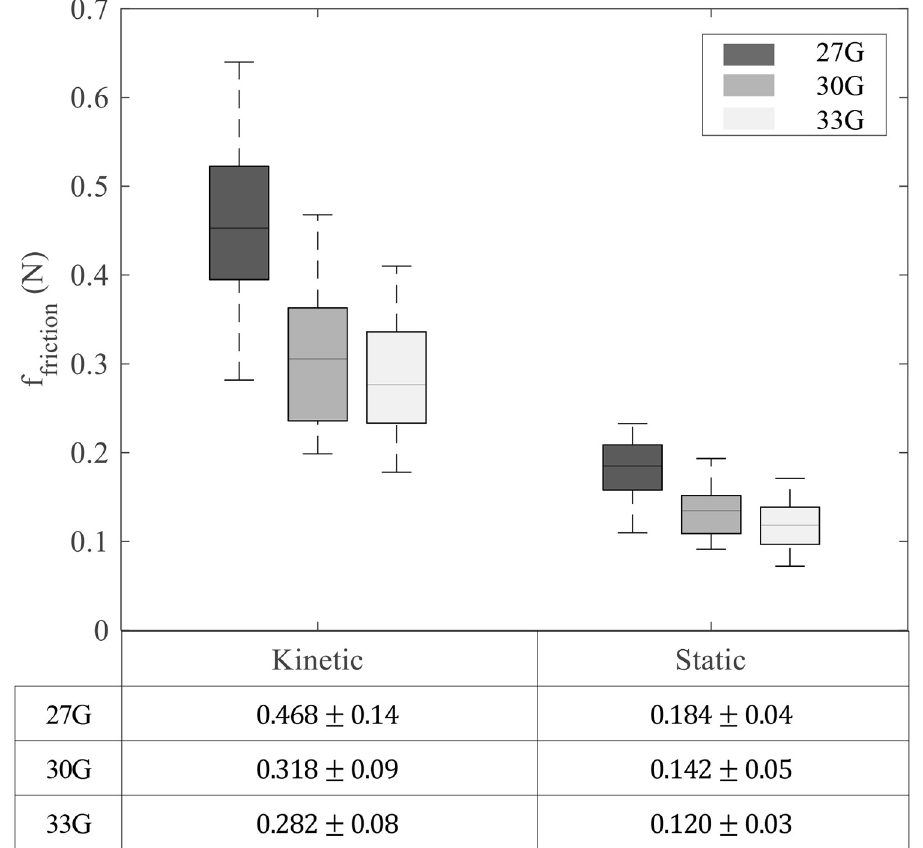
Fig 5. Kinetic friction according to needle size and static friction when the needle stopped. Each subgroup contains 30 samples.